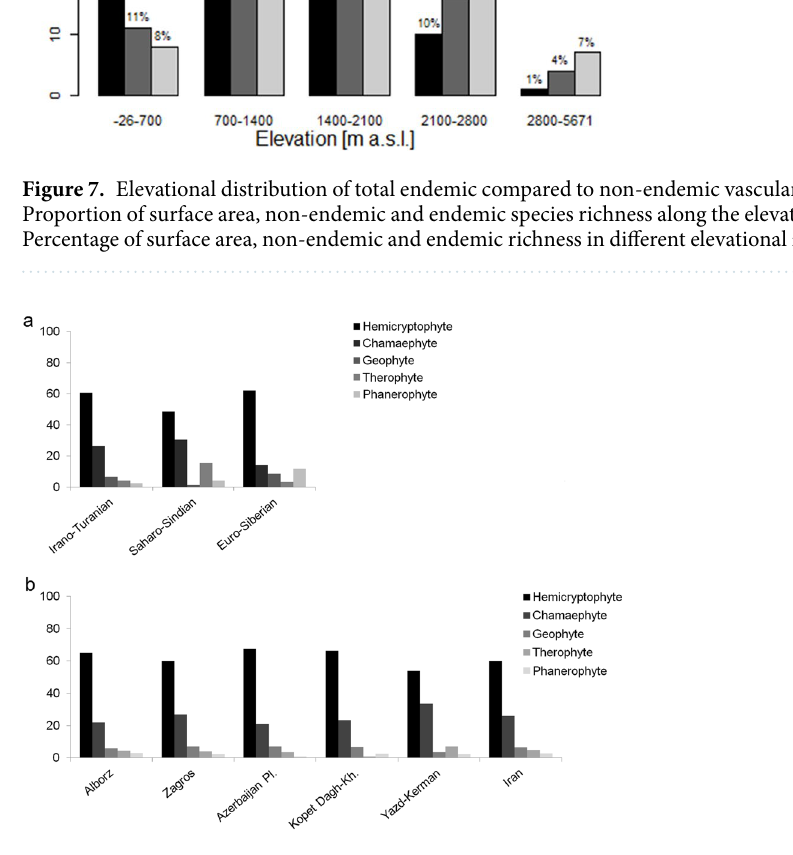
Figure 8. Life form spectra of the Iranian vascular flora in ( a ) phytogeographical regions and ( b ) areas of